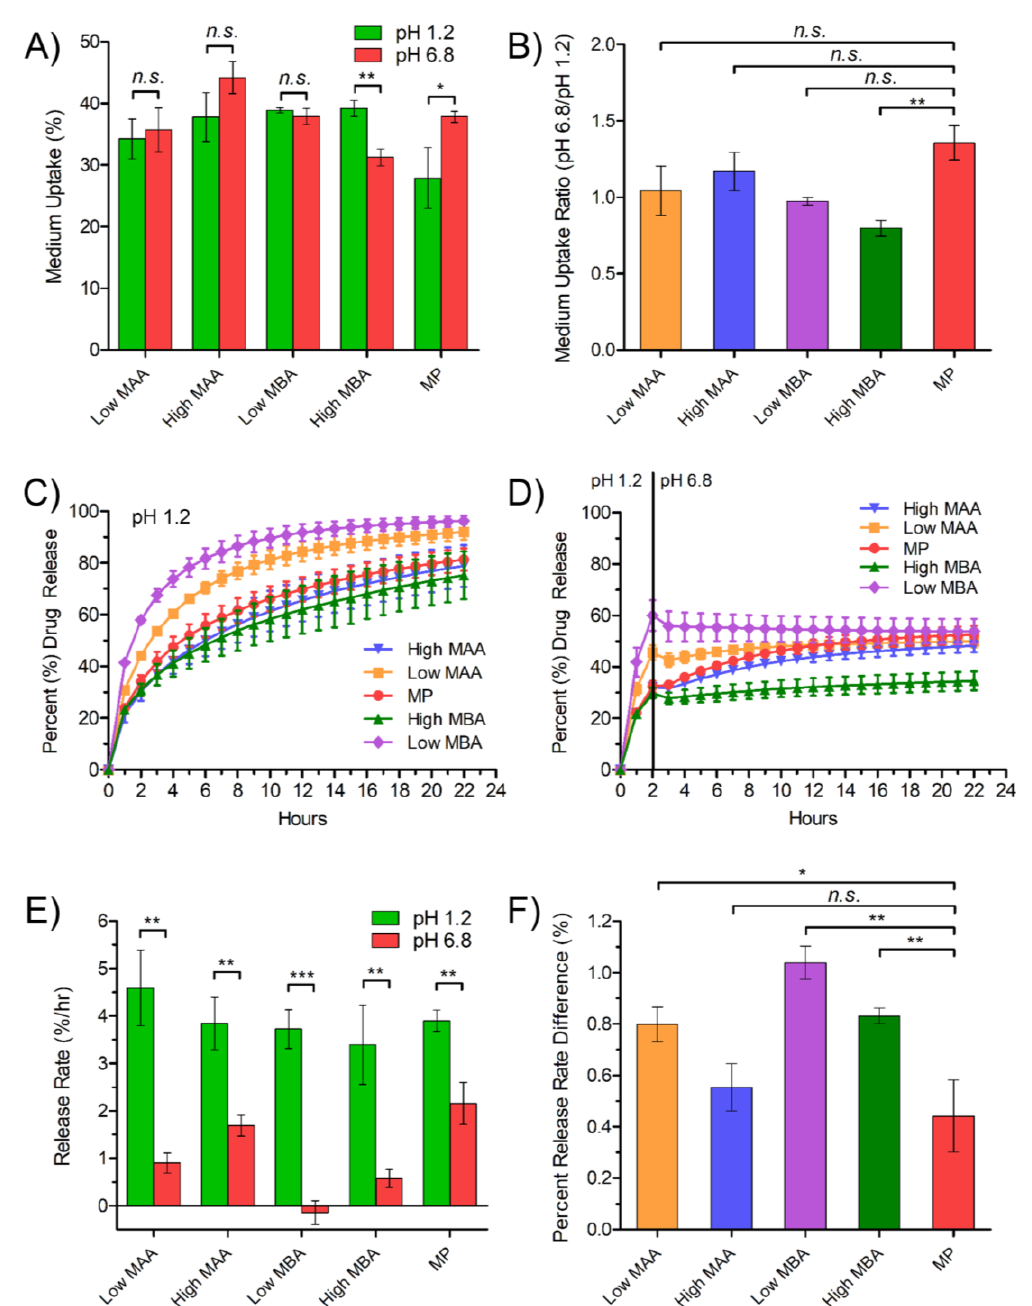
Figure 4. Effect of various TPN compositions on medium uptake and drug release rate. ( A ) Medium uptake from free-films at pH 1.2 or pH 6.8, ( B ) medium uptake ratio at pH 6.8 and 1.2, ( C ) drug release in pH 1.2 medium, ( D ) drug release in medium with pH transition from pH 1.2 to 6.8, ( E ) drug release rates from 0 – 2 h at pH 1.2 and 3 – 8 h at pH 6.8, and ( F ) percent release rate difference.